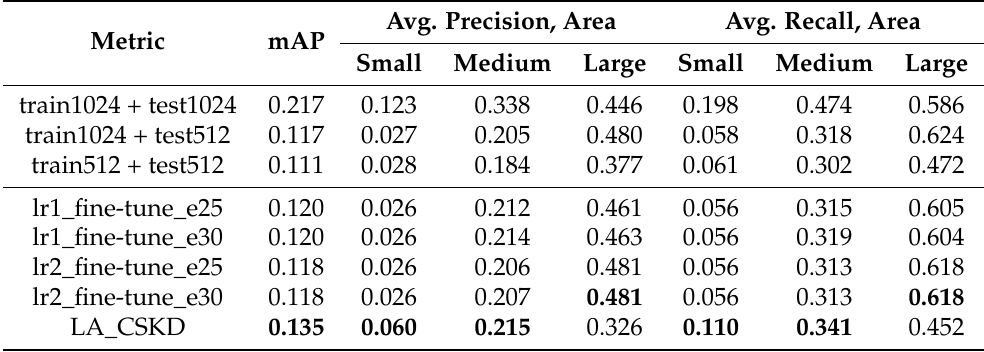
Table 9. Fine-tuning results from “train1024” pre-trained model with 2 learning rate setting ways, and the result of CSKD with LA. lr1_fine-tune_e25 means the 25th fine-tuning epoch with the second learning rate setting way. Bold font indicates the best